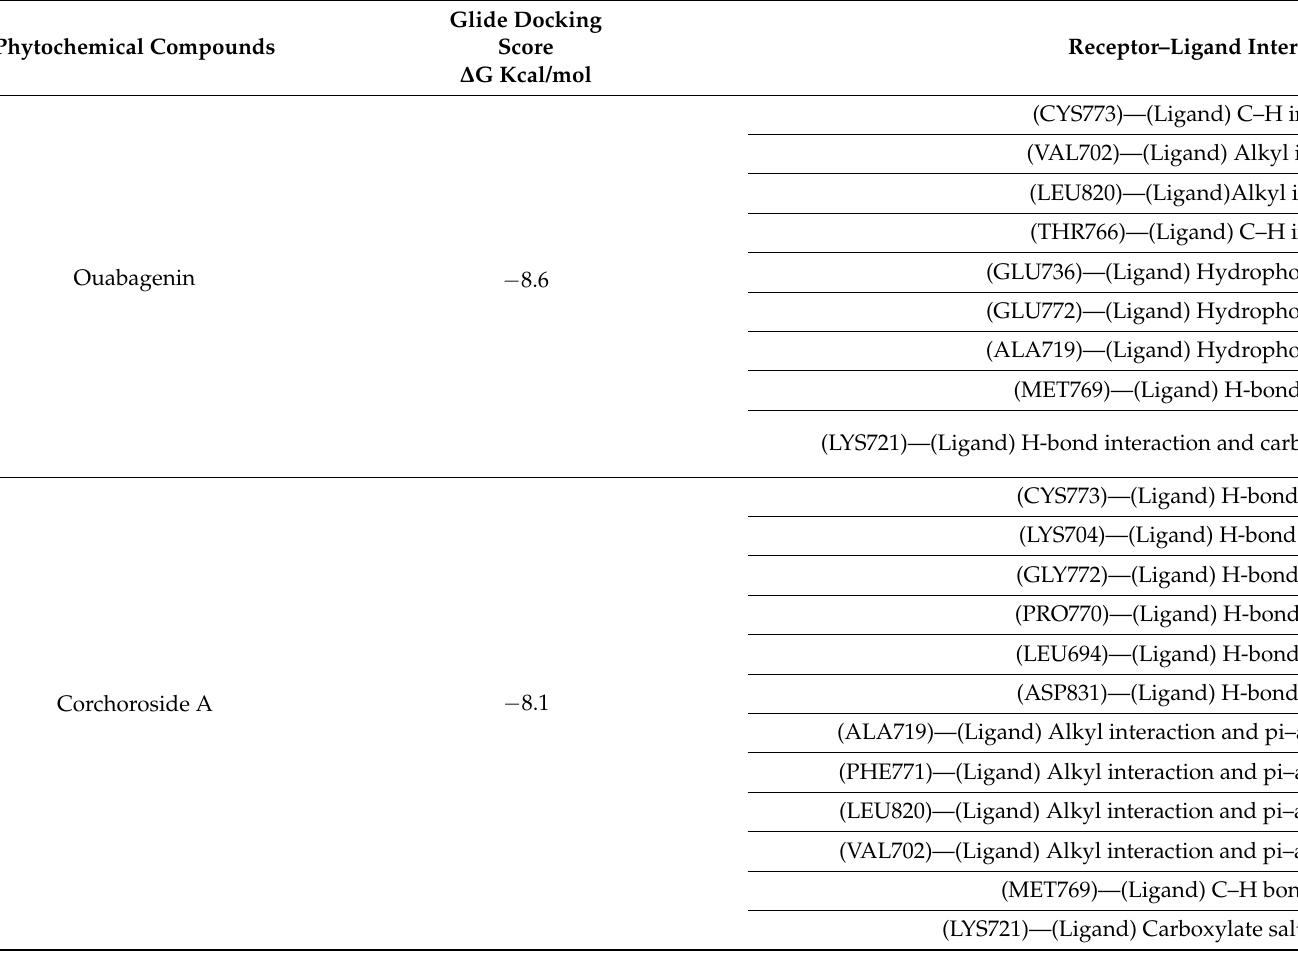
Table 4. Glide docking score and interacting residues in the molecular docking analysis of identified bioactive metabolites with EGFRK